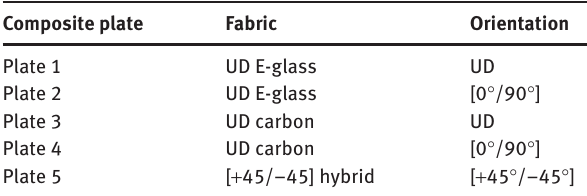
Table 2: Manufactured composite plate configurations.